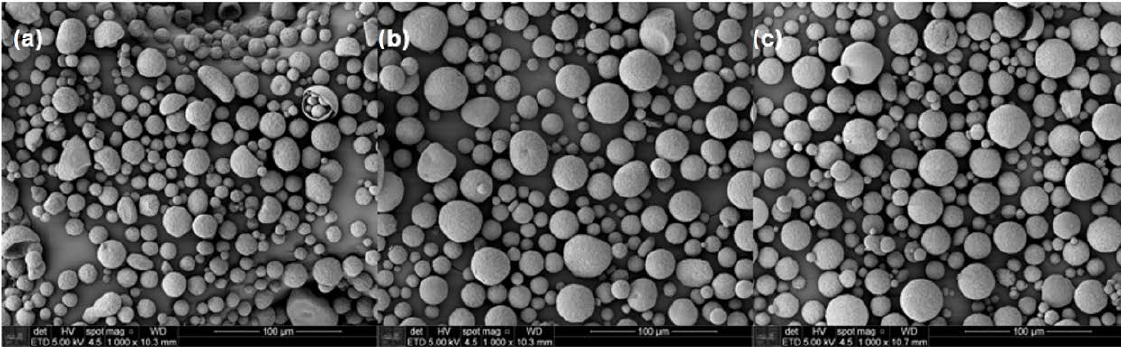
Figure 2. SEM micrographs of microcapsules with urea encapsulate of ( a ) polymer poly(3-hydroxybutyrate) (PHB), ( b ) PHB/MMT, and ( c ) PHB/OMMT.